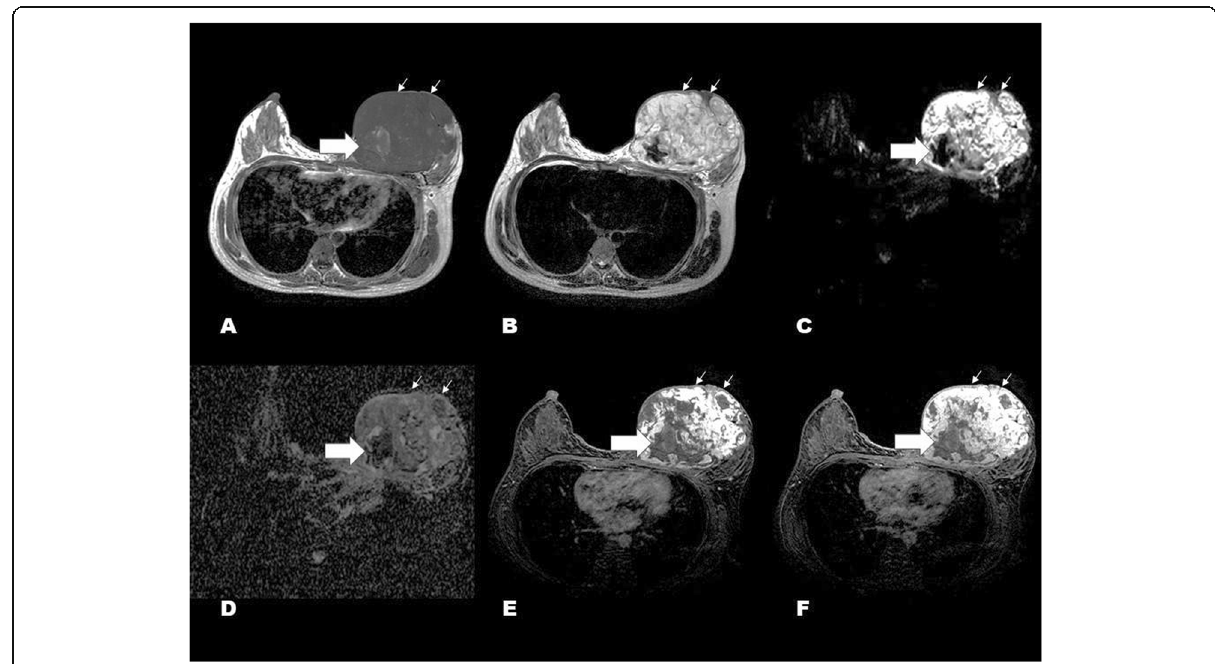
Fig. 2 MRI of the breast revealed a large low T1 ( a ), high T2 ( b ) signal intensity mass (thin arrow) occupying the entire left breast with ‘ blood lake ’ (thick arrow) within. It demonstrated restricted diffusion on DWI and ADC ( c , d ), rapid enhancement post-contrast administration with progressive and prolonged enhancement in the delayed phase ( e , f